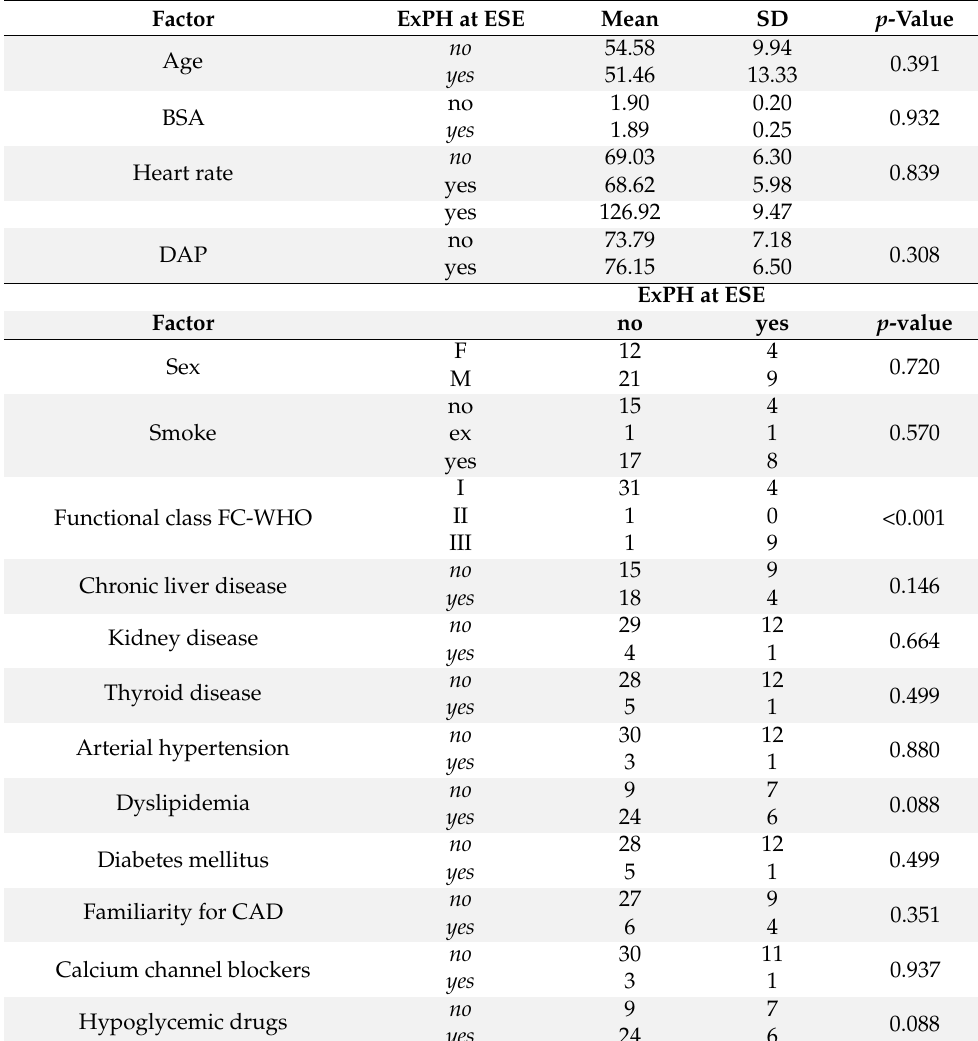
Table A2. Demographics, medical history and medication use according to presence and absence of ExPH at